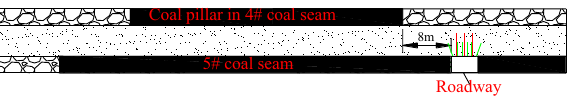
Figure 10. The location and support of roadway.